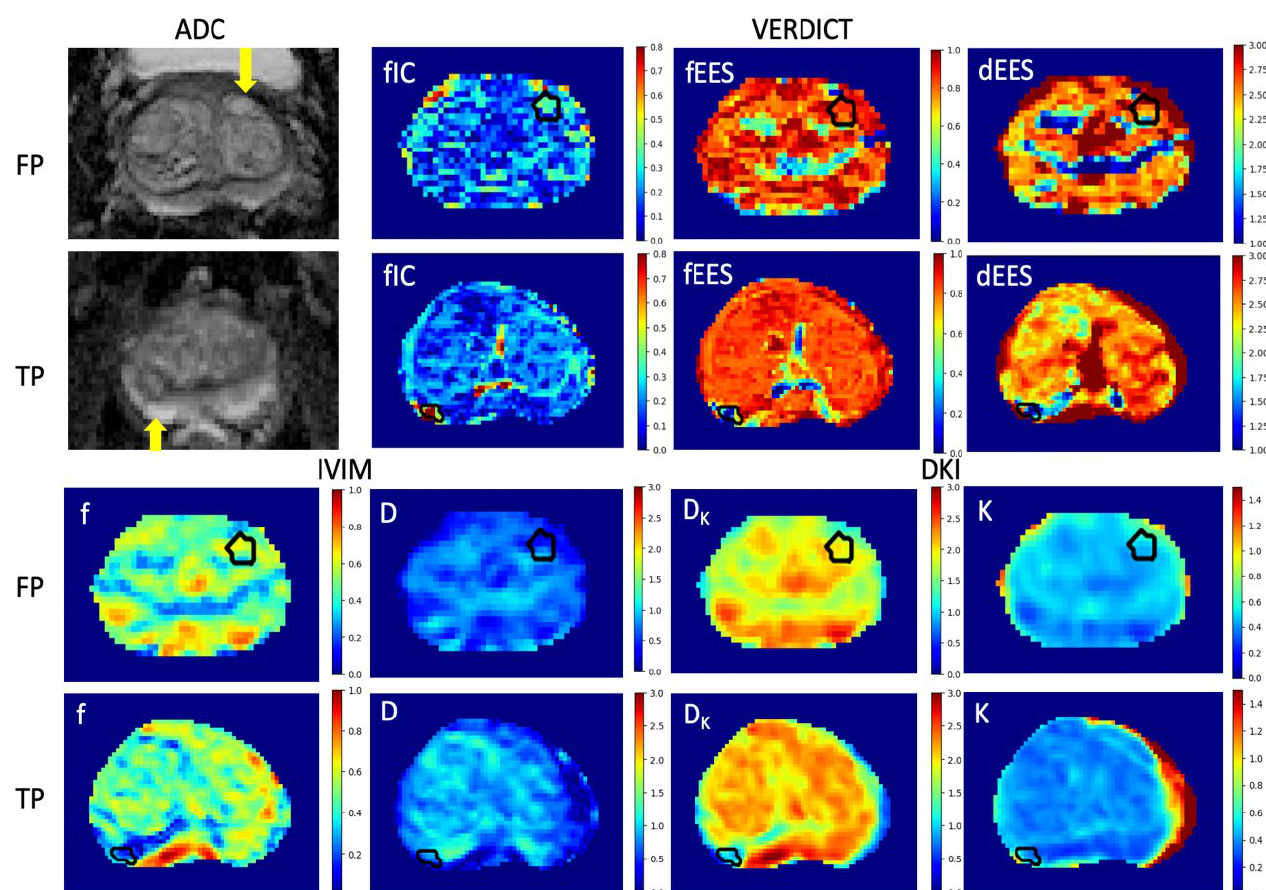
Figure 3. Parametric maps obtained using the IVIM, DKI and VERDICT models in a 70-year-old patient with a false positive lesion and a 72-year-old patient with a true positive lesion. Only the parameters which successfully differentiated between the two lesion types are included, as well as the clinical ADC maps. We observed that the VERDICT maps highlight the true positive lesion most conspicuously, and the VERDICT f IC also distinguishes the false positive lesion from the surrounding